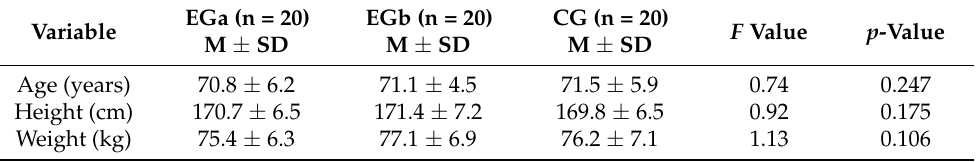
Table 1. Background characteristics of the participants in the cross-sectional study.